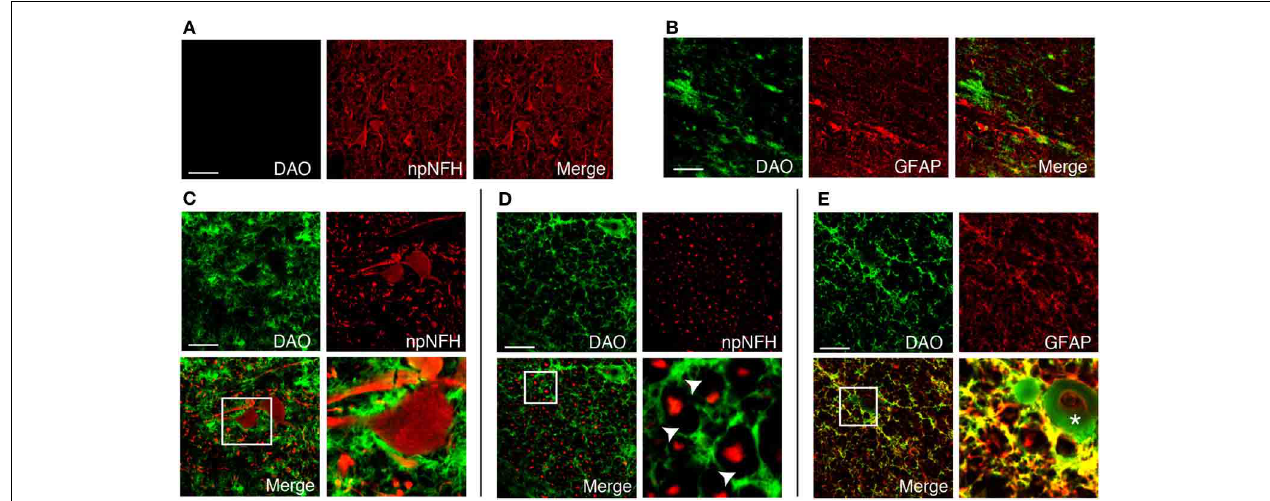
FIGURE 3 | Cellular distribution of DAO enzymatic activity in human corticospinal tract. DAO enzyme histochemistry in the gray (A) or white (B) matter of PMC, thoracic spinal VH (C) , or LCST (D,E) in humans was double stained with npNFH, a marker for motor neurons,